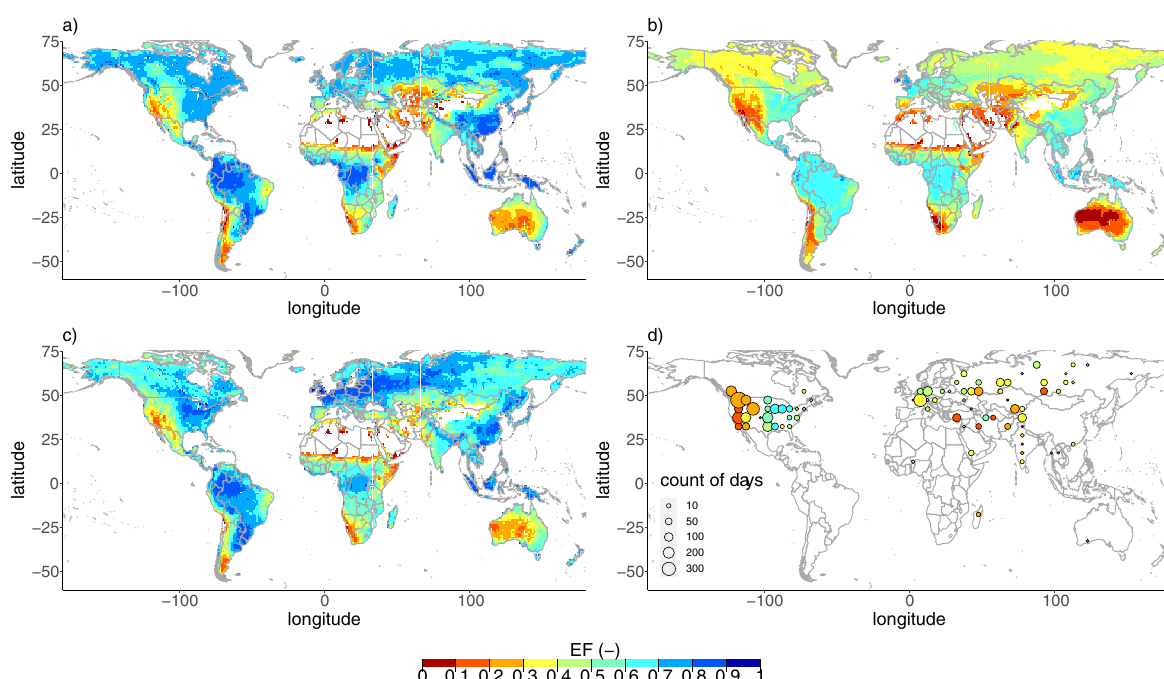
Fig. 2 Global estimates of mean surface fl ux partitioning. Colors denote the evaporative fraction averaged over the timespan of the respective data product after fi ltering for warm days (ERA5 temperature > 278 K) and availability of all gridded data products: a GLEAM, 2003 – 2017, b FLUXCOM, 2001 – 2015, and c ERA5, 1981 – 2017 (see “ Data ” in “ Methods ” ). d Evaporative fraction inferred from balloon soundings using CLASS4GL in colored circles, averaged over all stations from the morning to the afternoon sounding for within a 5.0° × 5.0° grid cell and all available sounding days. The sizes of the circles correspond to the amount of available sounding days.